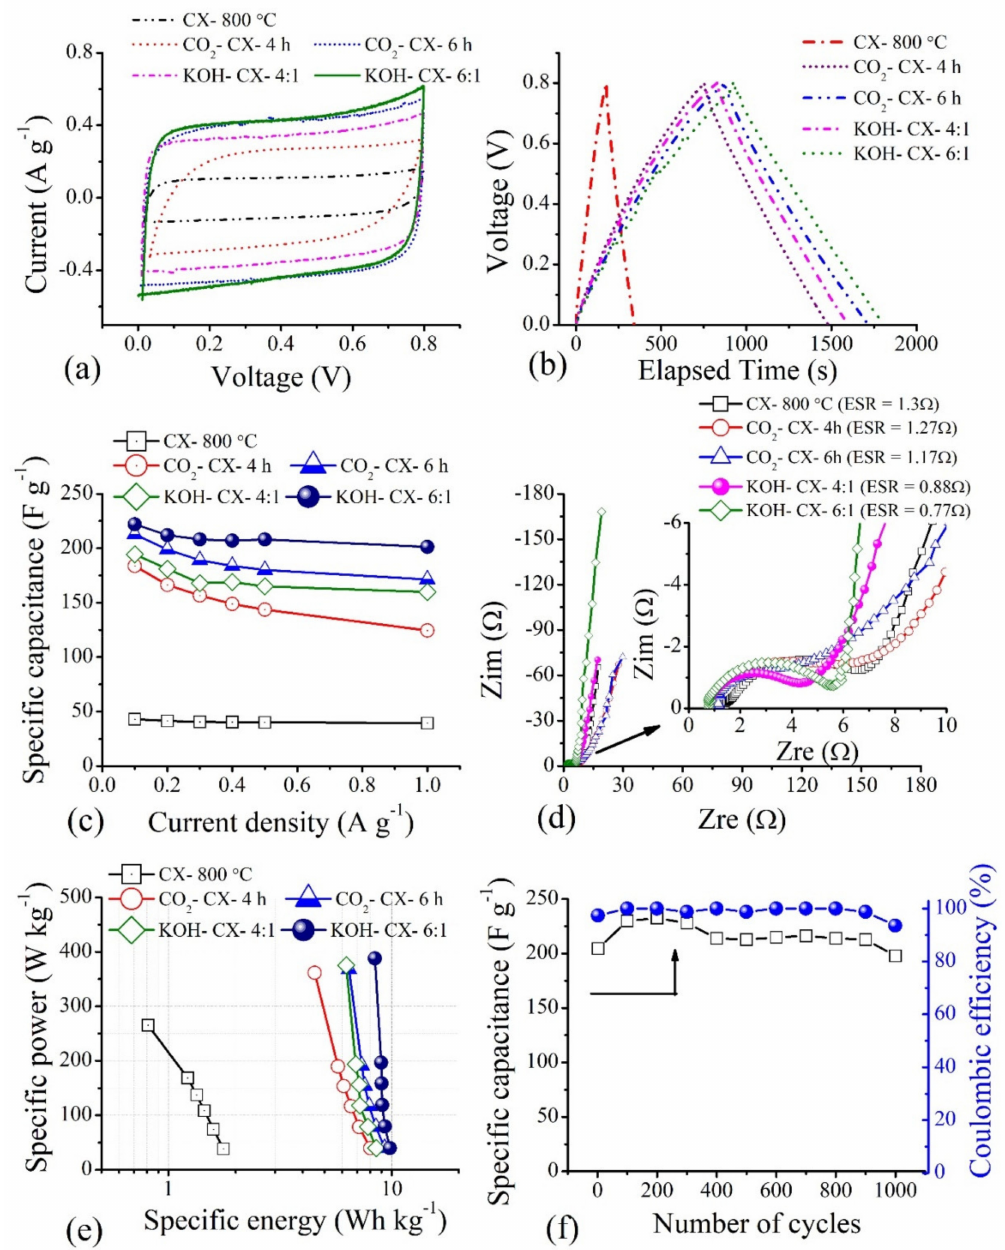
Figure 11. Electrochemical performance of activated CX electrodes: ( a ) CV at 5 mV s − 1 , ( b ) CP at 0.1 A g − 1 , ( c ) rate capability with current density, ( d ) Nyquist plot, ( e ) Ragone plot, and ( f ) cyclic stability at 1 A g − 1